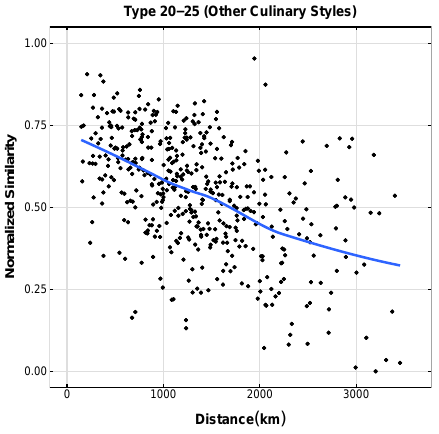
Figure 7. Scatter plot showing the relationship between cities’ similarities and their geographic distances, (from the perspective of cuisine type